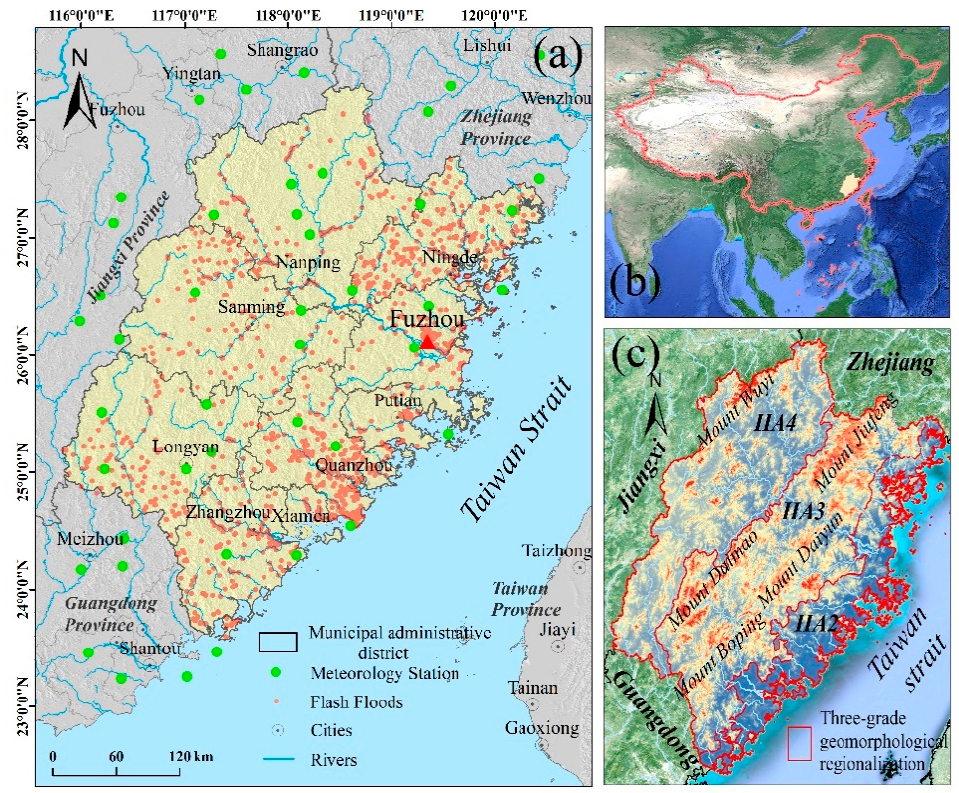
Figure 1. The study area: ( a ) The spatial distribution of the flash floods in Fujian Province; ( b ) The geographical position of Fujian in China; ( c ) Three-grade geomorphic regionalization in Fujian